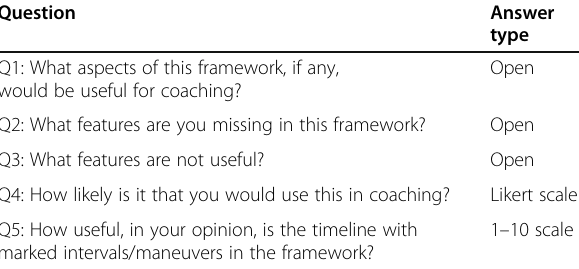
Table 2 Questions on the user